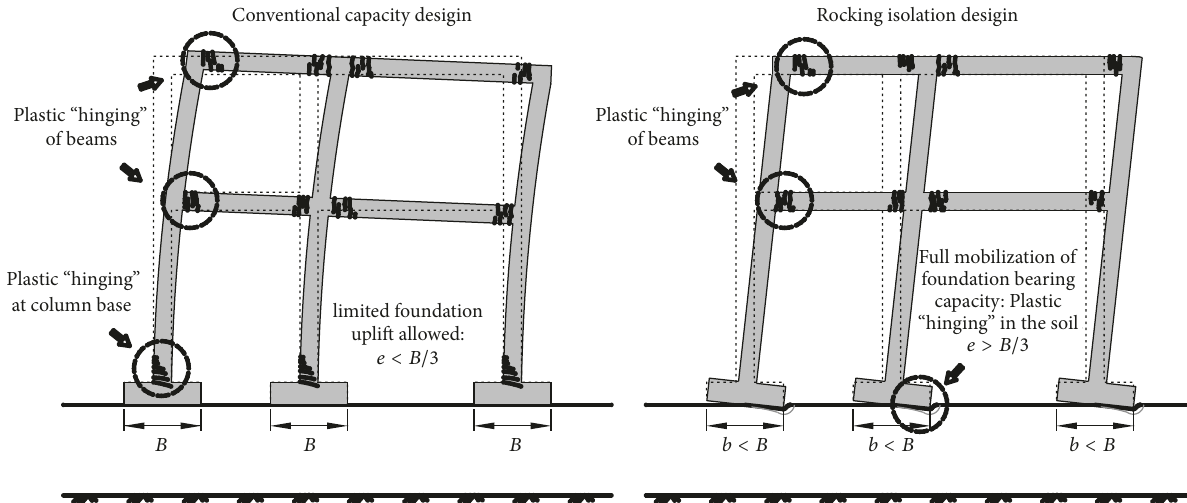
Figure 2: The principle of the new idea “rocking isolation” [11,